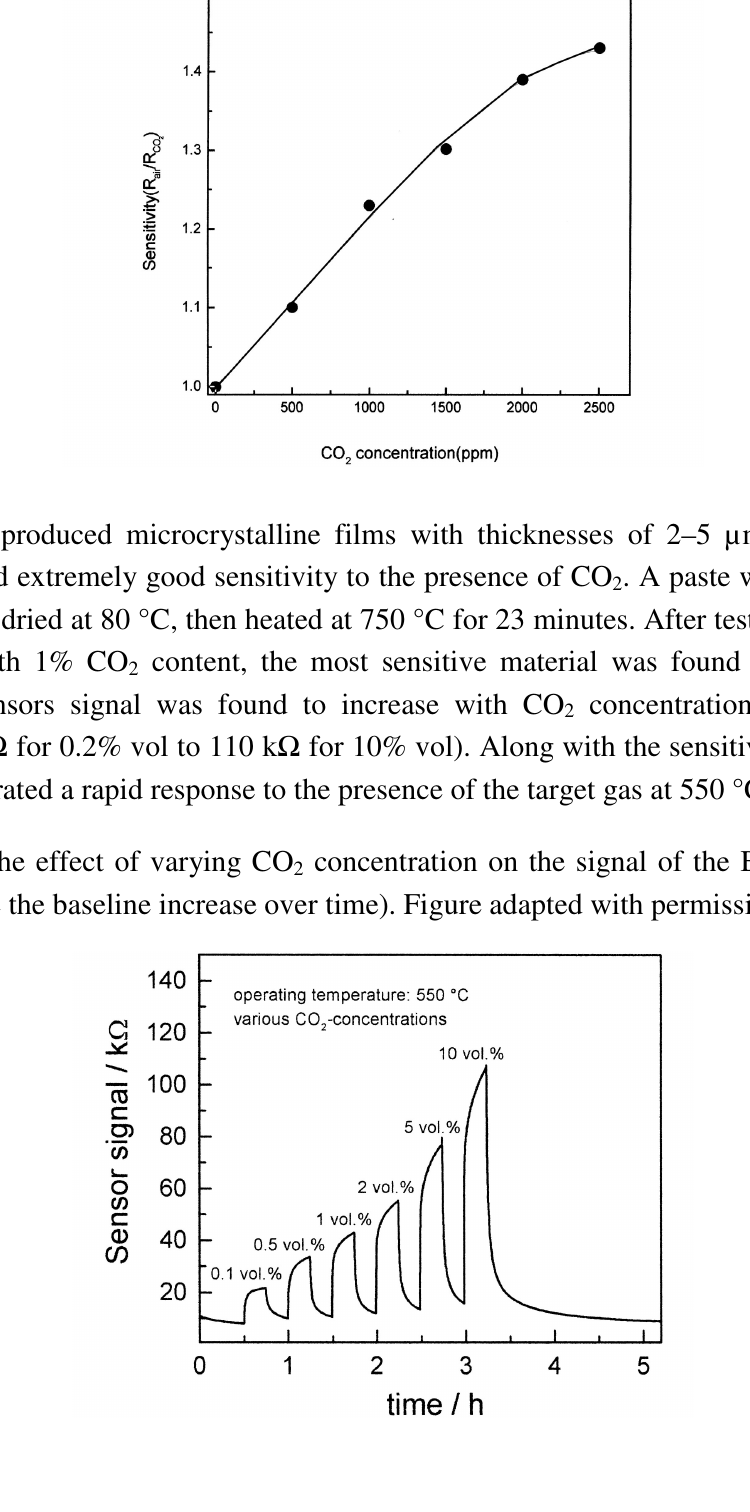
Figure 13. The responsivity change of the Lanthanum film to carbon dioxide upon increasing concentration (temperature unreported). Figure adapted with permissions from [57].